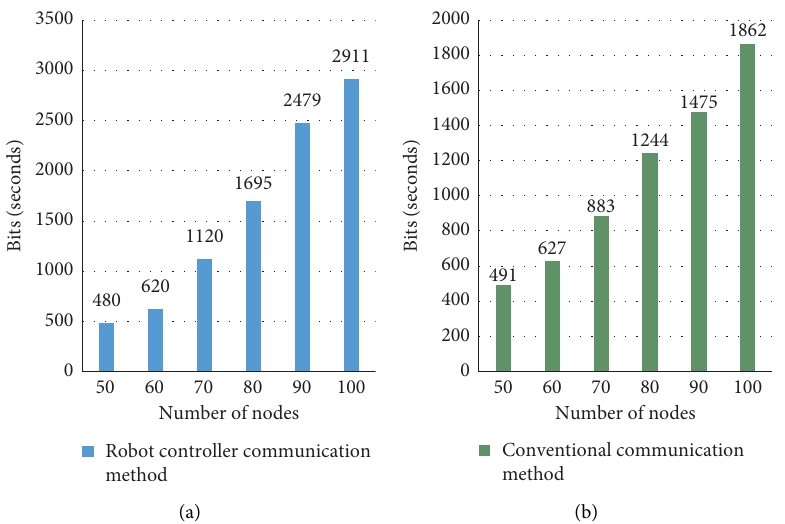
Figure 5: Test results of throughput. (a) Te results of this communication method. (b) Te results of the traditional communication method.